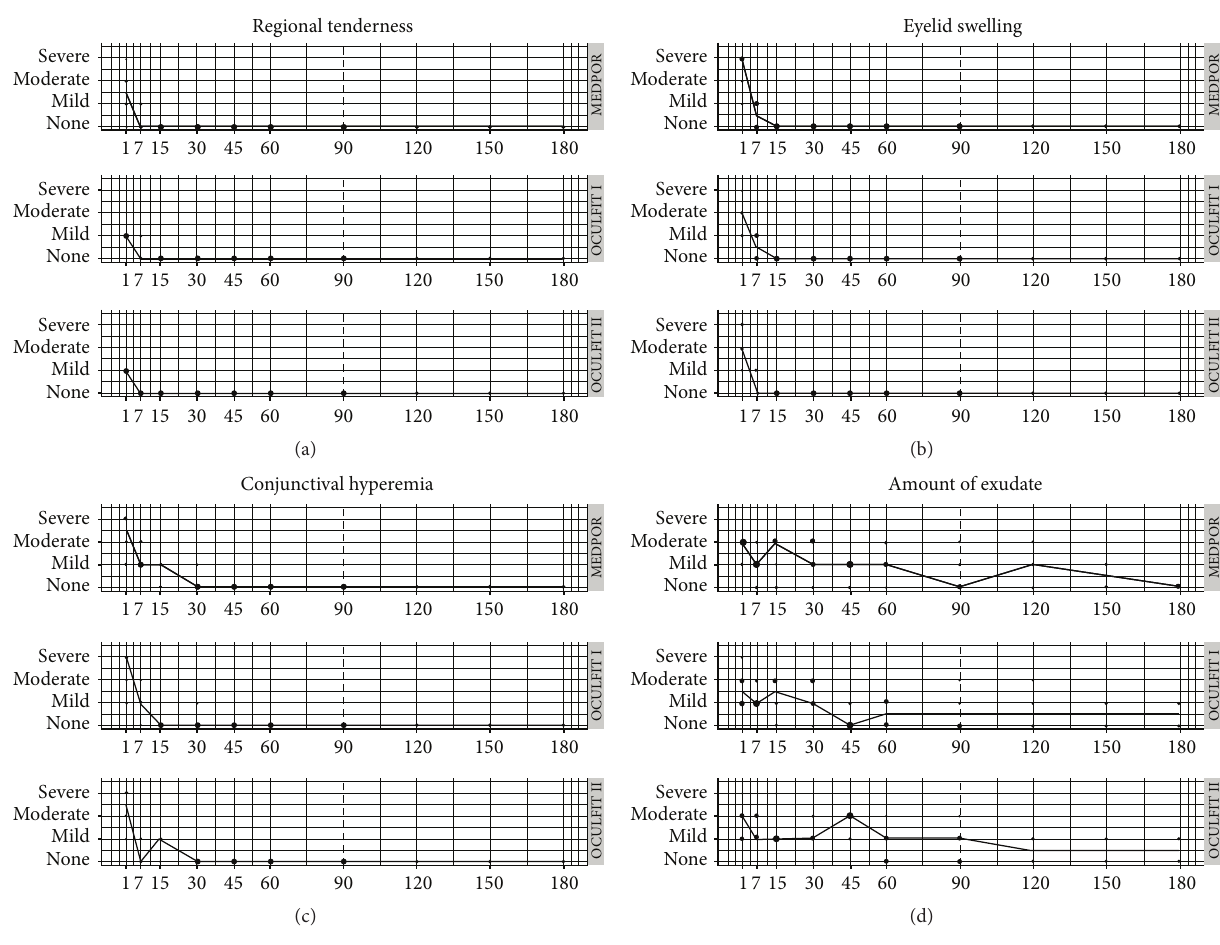
Figure 1: Clinical evaluation follow-up after orbital implantation. The severities of regional tenderness (a), eyelid swelling (b), conjunctival hyperemia (c), and amount of exudate (d) were recorded at each time point after insertion of the MEDPOR, OCULFIT I, and OCULFIT II implants. Clinical signs were graded as none, mild, moderate, or severe according to Hackett and McDonald scoring system [19]. Clinical examinations were performed on days 1, 7, 15, 30, 45, 60, 90, 120, 150, and 180 after implantation. Bubble sizes are proportional to the number of